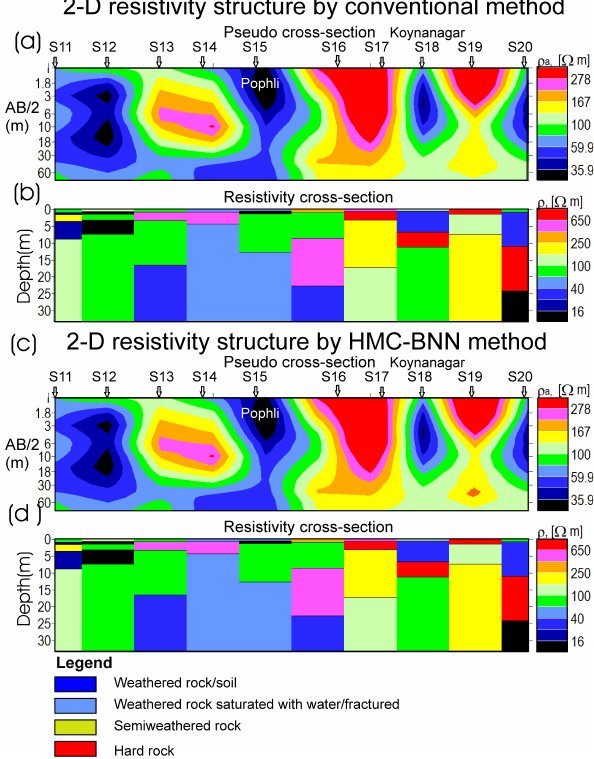
Fig. 10. Resistivity structure of sounding points s11–s20 by (a, b) singular value decomposition (SVD)-based conventional method (c, d) Hybrid Monte Carlo (HMC)-based Bayesian neural network (BNN)